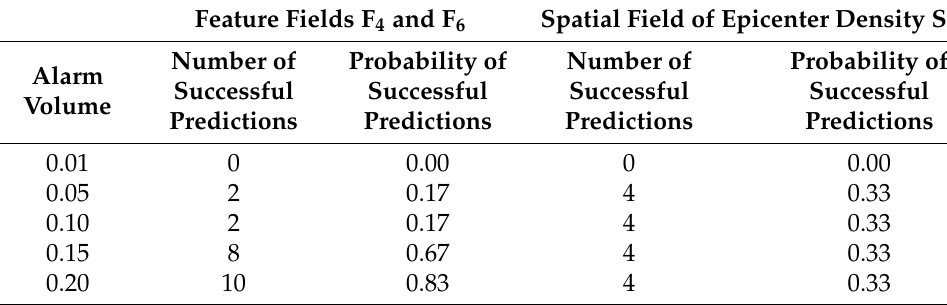
Table 4. California. Probabilities of predicting earthquakes with magnitudes m ≥